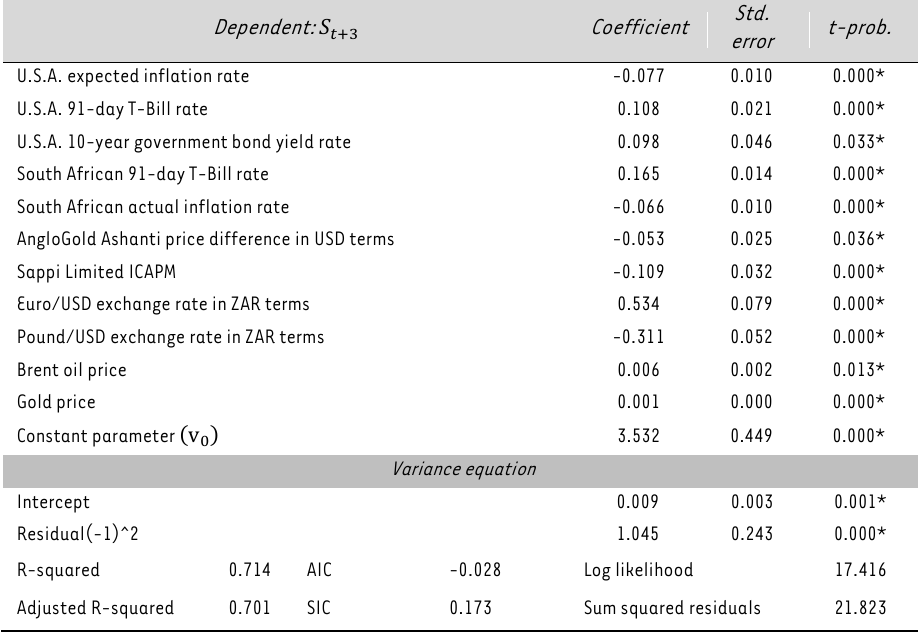
TABLE 8: Adjusted ARCH(1,0) estimation in level format